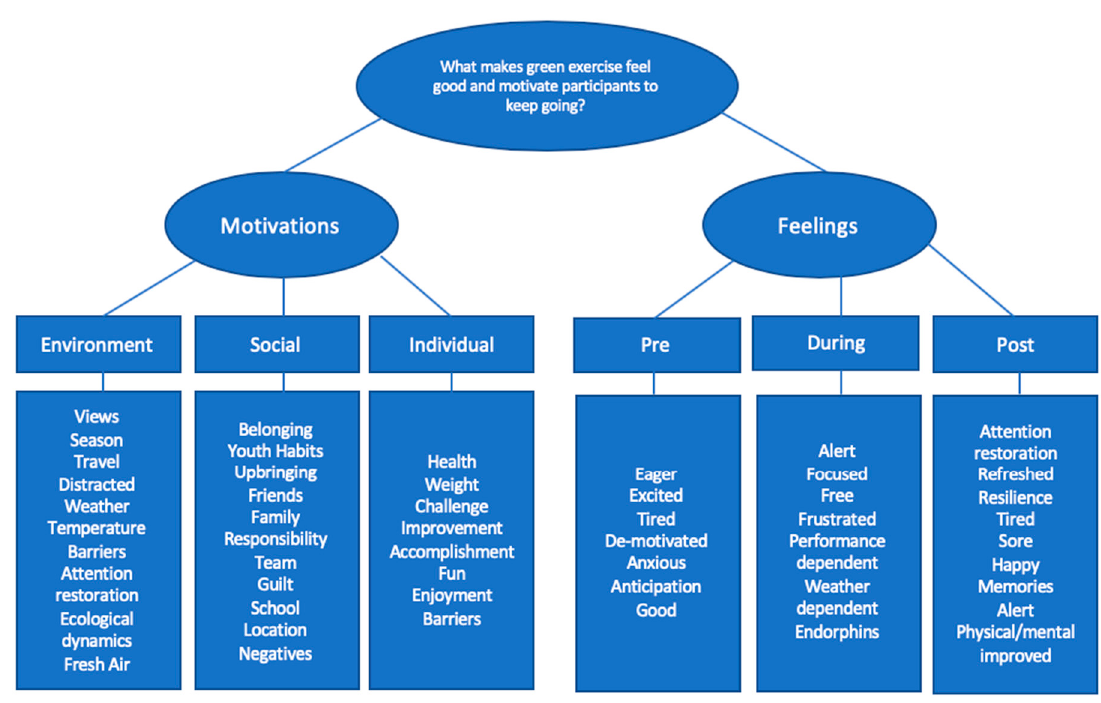
Figure 1. Codes presented as map.